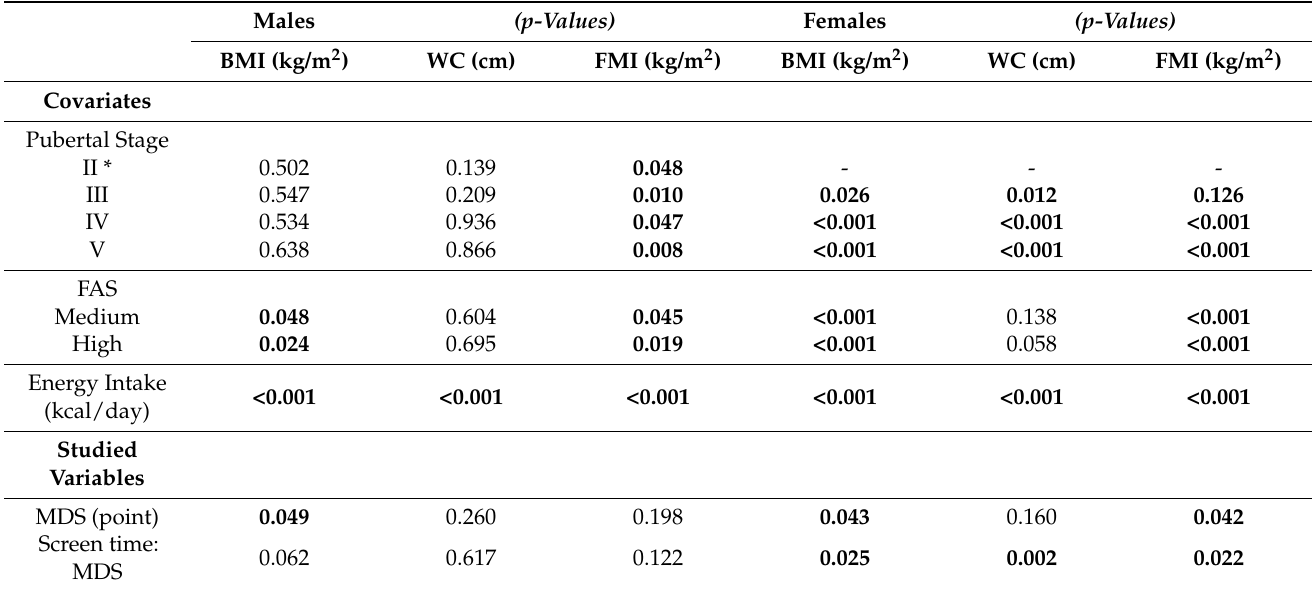
Table 3. Multiple linear regression models of screen time and Mediterranean diet score (MDS) interaction and covariates to predict body mass index, waist circumference and fat mass index displayed by